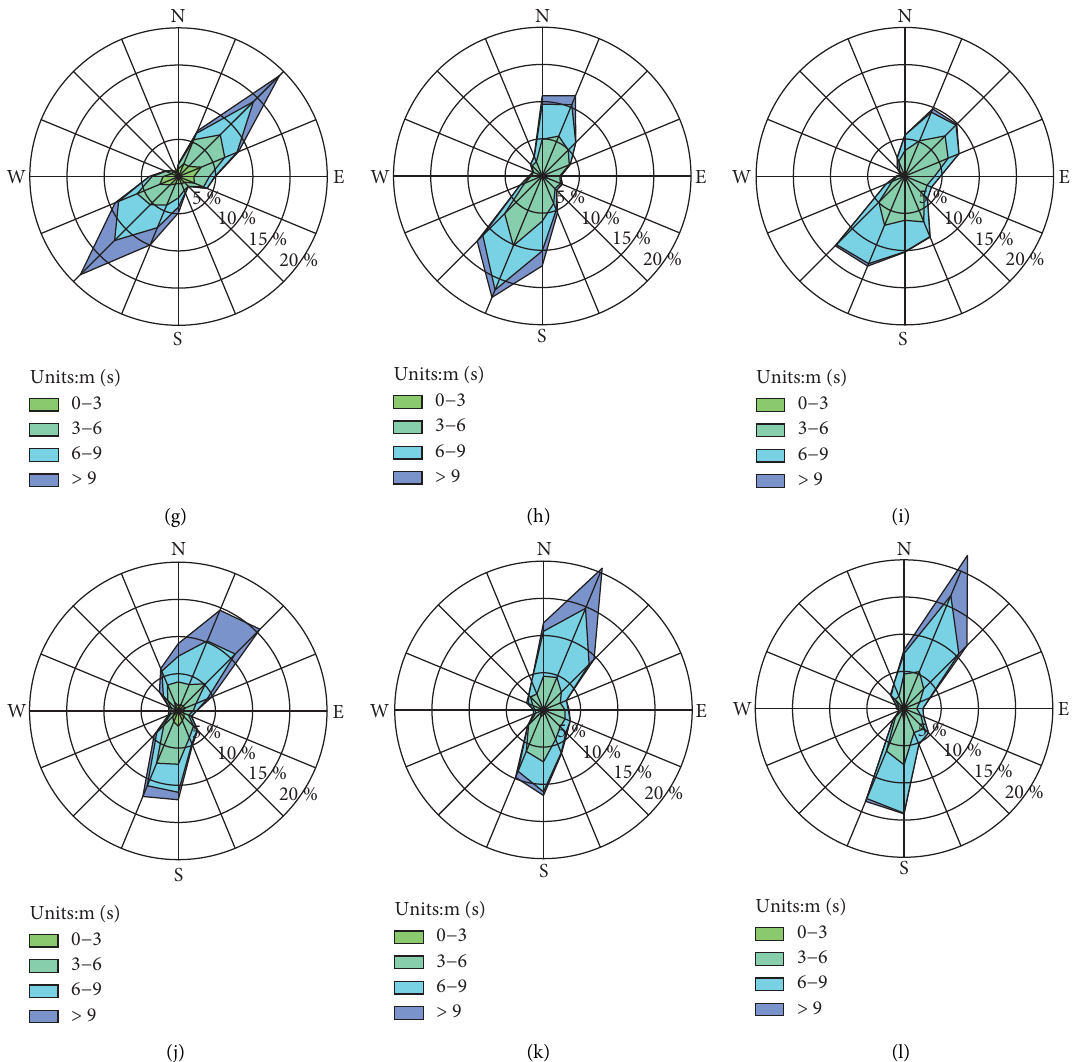
Figure 7: The wind rose plots for the observations, the ERA5 predictions and the MERRA2 predictions based on the ANN downscaling method. (a) T 1-Obs. (b) T 1-ERA5. (c) T 1-MERRA2. (d) T 2-Obs. (e) T 2-ERA5. (f) T 2-MERRA2. (g) T 3-Obs. (h) T 3-ERA5. (i) T 3-MERRA2.